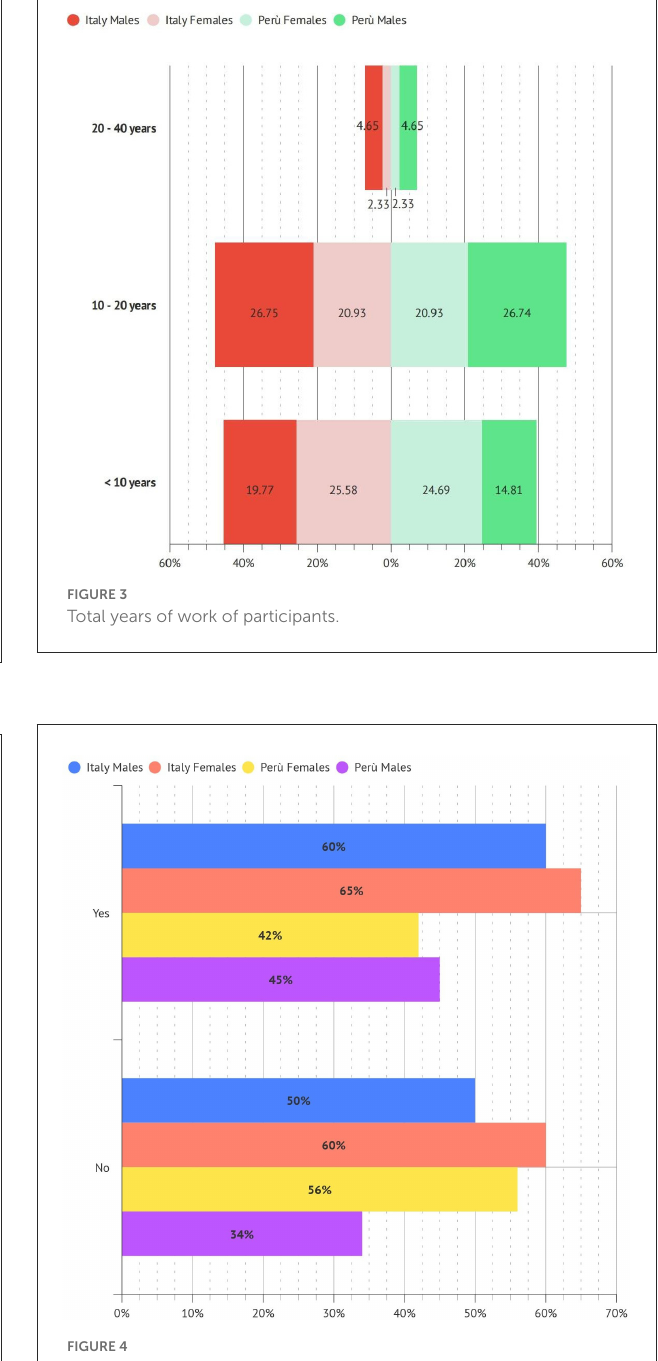
FIGURE2 Hours of work per day.